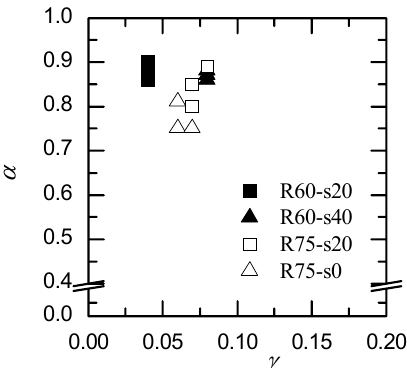
Fig. 11 Reaction rate, α , and preferential generation rate of CO, γ , in the cases of parallel-type multi-jet ( Q = 1.5L/min and Q = 35L/min). f a R60-s40 case, the magnitude of the flow heading toward the centerline near the central nozzle exit is decreased compared with the R60-s20